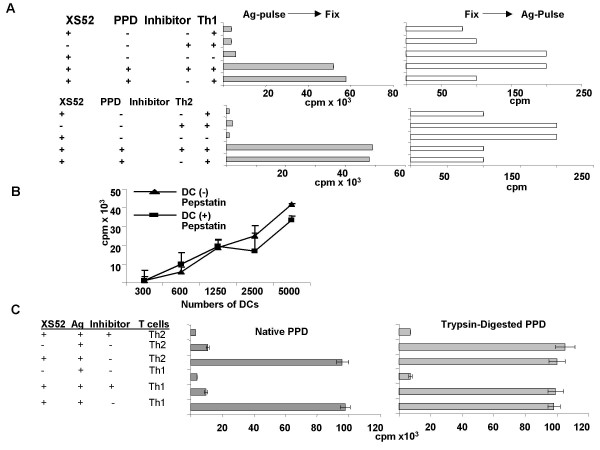
Failure of pepstatin A to inhibit the Ag presenting capacity of PPD-pulsed and fixed XS52 DC: (A) γ-irradiated XS52 DC were pulsed with PPD and then fixed with paraformaldehyde (left panels). Alternatively, XS52 DC were first fixed and then pulsed with PPD. Subsequently, the XS52 DC were cultured with the PPD-specific Th1 or Th2 clone in the presence or absence of pepstatin A. Data shown are the mean ± SD (n = 3) of 3H-thymidine uptake. (B): Allogeneic splenic T cells isolated from CBA mice (5 × 105 cells/well) were cultured for 4 days with the indicated numbers of γ-irradiated XS52 DC in the presence or absence of pepstatin A. Data shown are the mean ± SD (n = 3) of 3H-thymidine uptake. (C): γ-irradiated XS52 DC were pulsed for 8 hr with either native PPD or trypsin-digested PPD in the presence or absence of pepstatin A. XS52 DC were then cocultured for 4 days with PPD-reactive Th1 or Th2 clones in the presence or absence of pepstatin A. Cocultures were then pulsed for 18 hr with 3H-thymidine and then harvested using a β-counter.